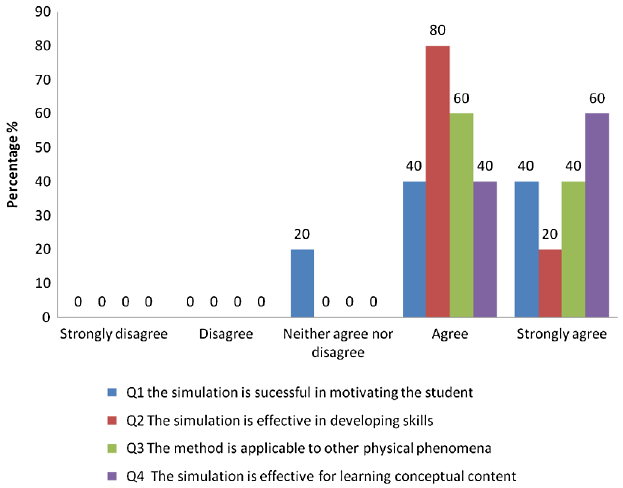
FIG. 9 (color online). Questionnaire used on the students’ assessment.